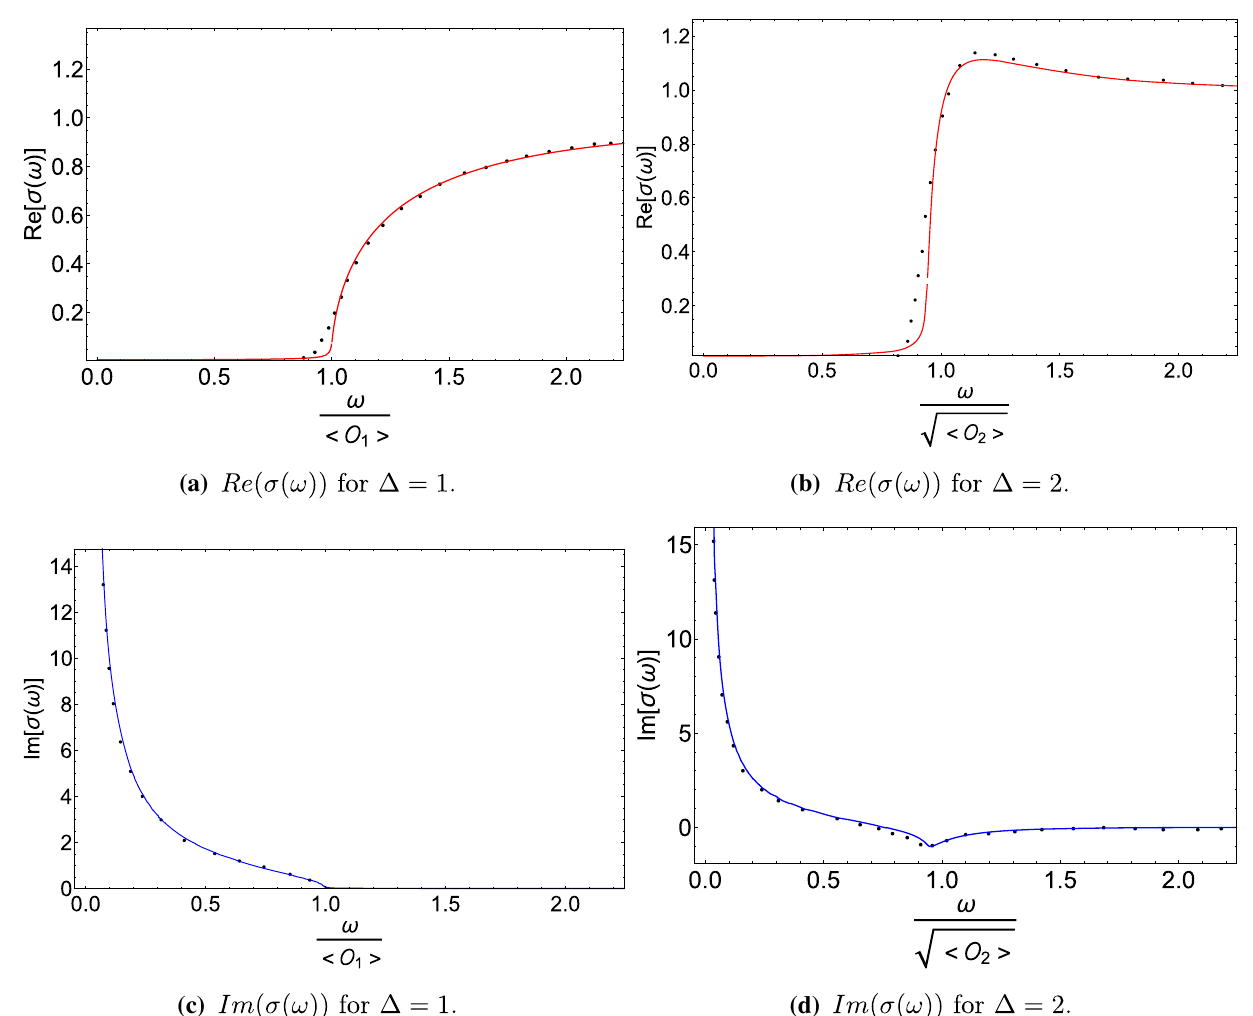
Fig. 6 Analytic results (real lines) vs numerical results (dotted lines). a , b Plots of Re (σ(ω)) in Eqs. (5.6) and (5.7). Dot points are numerical results in Fig. 3 of Ref. [1]. c , d Plots of Im (σ(ω)) . Dot points are from Fig. 4 of Ref. [1]. In all cases T / T c = 0 .